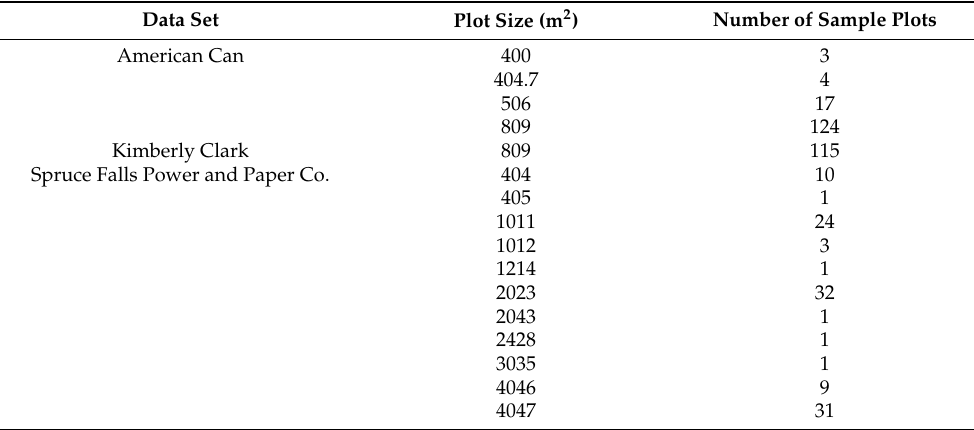
Table A2. Plot size distribution for the sample plot data in the three data sets used in this study maintained by the Ontario Ministry of Natural Resources and